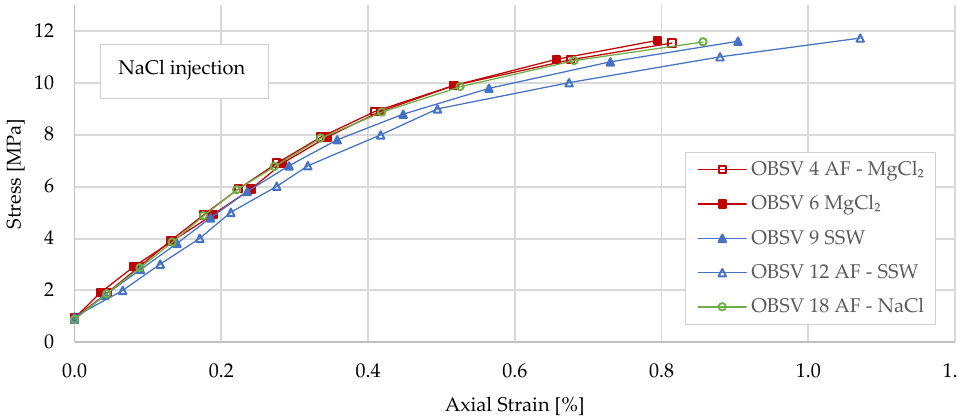
Figure 2. Axial creep strain during loading with injection of NaCl.